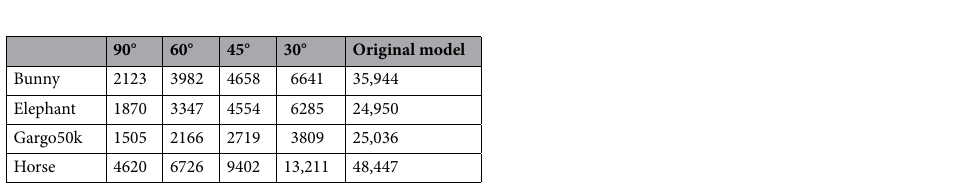
Table 2. Results of different feature points under rotation angles 90°, 60°s, 45° and 30° with